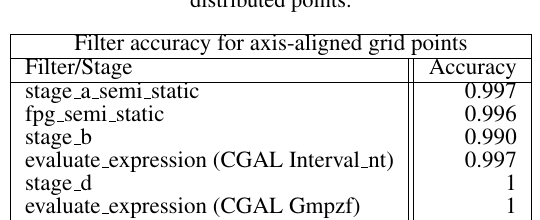
Table 2. Time added by a filter over a non-robust implementation of the 2D orientation predicate during the computation of a Delaunay triangulation of uniformly distributed points.